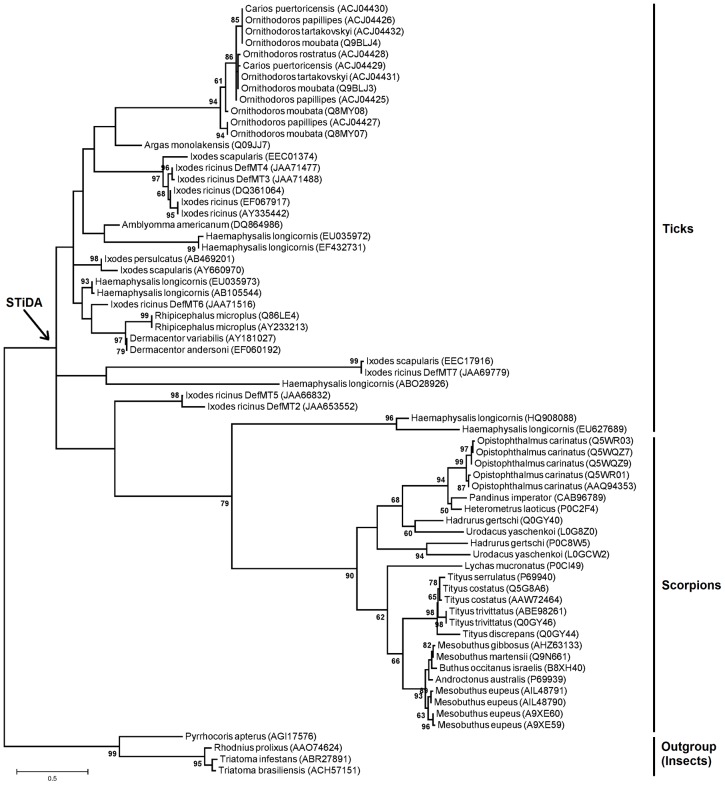
Phylogenetic tree of defensins and position of Scorpions-Ticks Defensins Ancestor (STiDA). The maximum likehood (ML) phylogenetic tree was built using amino acid sequences of defensins from ticks and scorpions (Supplementary file 1). Names of species are shown. All sequences were used to predict the sequence of STiDA; (Figure 2). The phylogenetic position of STiDA is shown (arrow). Defensins from the insects Rhodnius prolixus (Accession number: AAO74624), Triatoma infestans (Accession number: ABR27891), T. brasiliensis (Accession number: ACH57151), and Pyrrhocoris apterus (Accession number: AGI17576) were used as outgroup. Numbers on internal branches are the bootstrap values (1000 replicates).